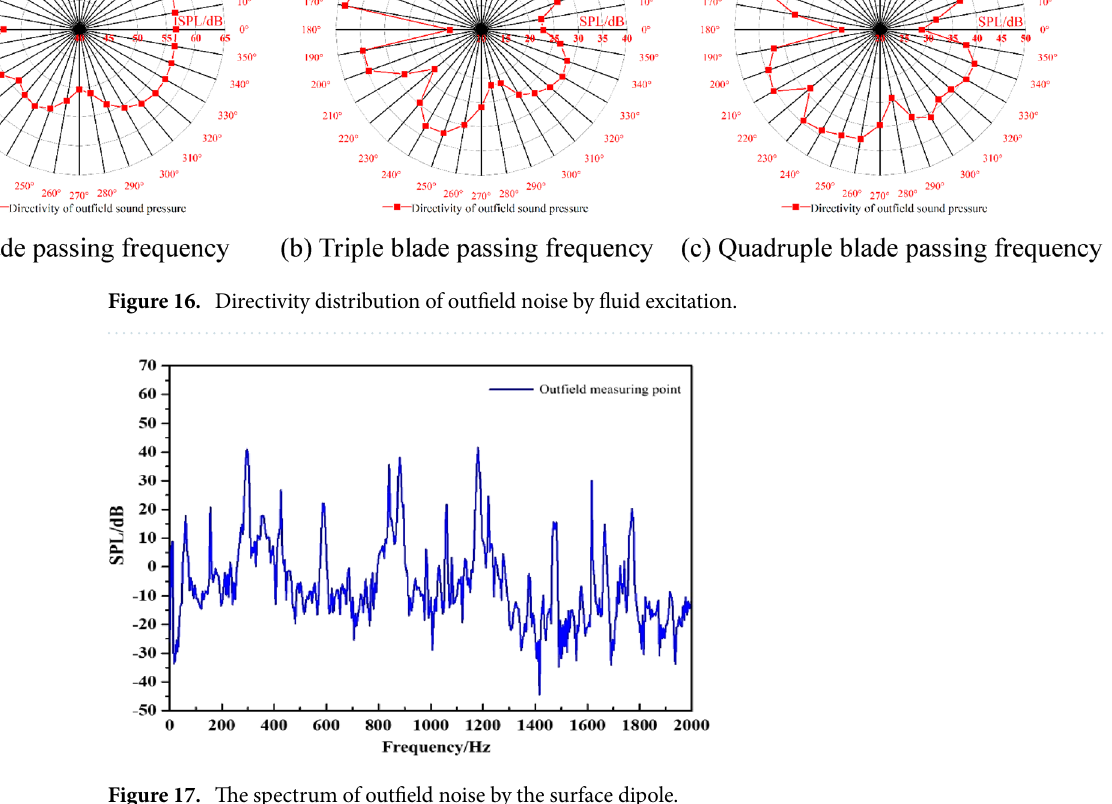
Figure 17. The spectrum of outfield noise by the surface